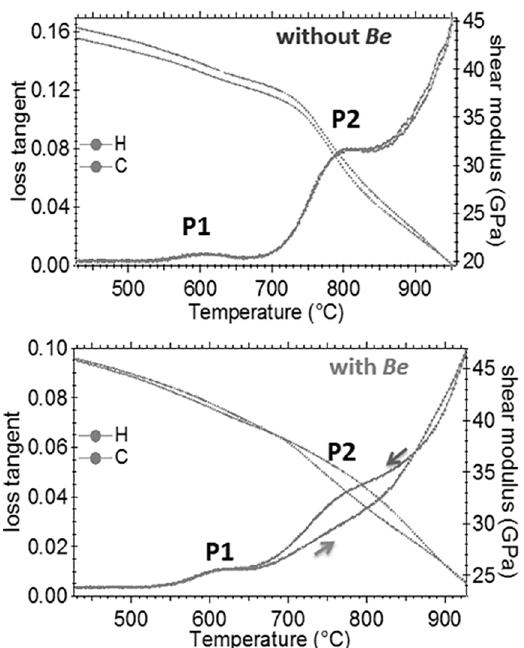
Figure 2. IF spectra for the alloy "without Be" and "with Be" in the CW state after several heating and cooling cycles. P1 and P2 can be associated to the diffusion process and to the twin boundary motion, respectively These characteristic spectra were also obtained during scans at different frequencies, with a slight shift of temperature peaks due to thermal activation. The presence of both the peak P1 and P2 on isothermal internal friction spectra, measured as a function of frequency, confirms the thermally activated character of the peaks. Data processing allowed to decompose the spectrum into its components, i.e. the two relaxation peaks and the high-temperature exponential background with the respective parameters. Internal friction curves were fitted by using the equations (1) and (2), describing a Debye peak and the exponential rise of mechanical loss at high temperature, respectively.